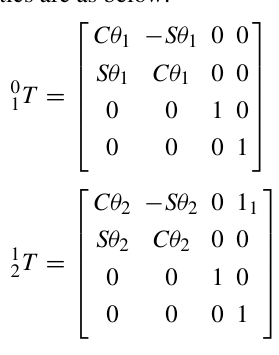
of squares of the ankle torque can guarantee the motion